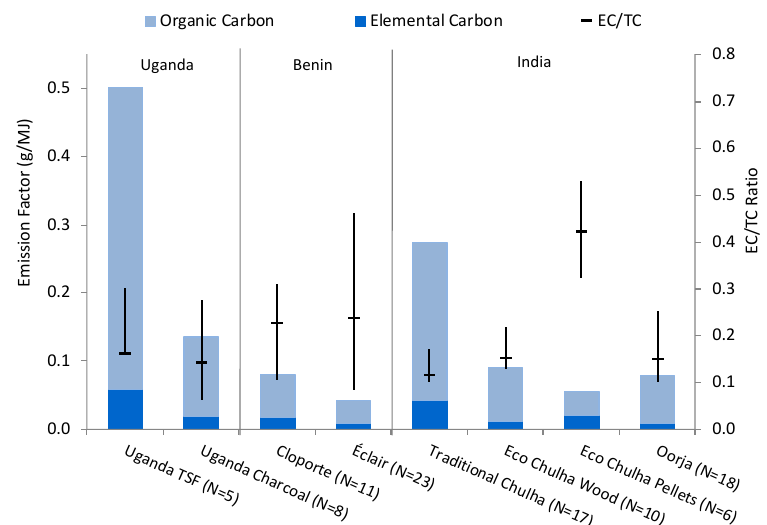
Figure 2. EC and OC emission factors and EC / TC ratios for fuel stove combinations for which quartz filters samples were collected. Mean EC and OC emission factors are presented as the blue bars, while the median EC / TC ratios are indicated by the black horizontal bar markers, with respective error bars representing their IQRs. Table 2. Comparison of elemental carbon / total carbon (EC / TC) interquartile range (IQR) emissions ratios from simple or traditional wood stoves. Results from this study are italicized.